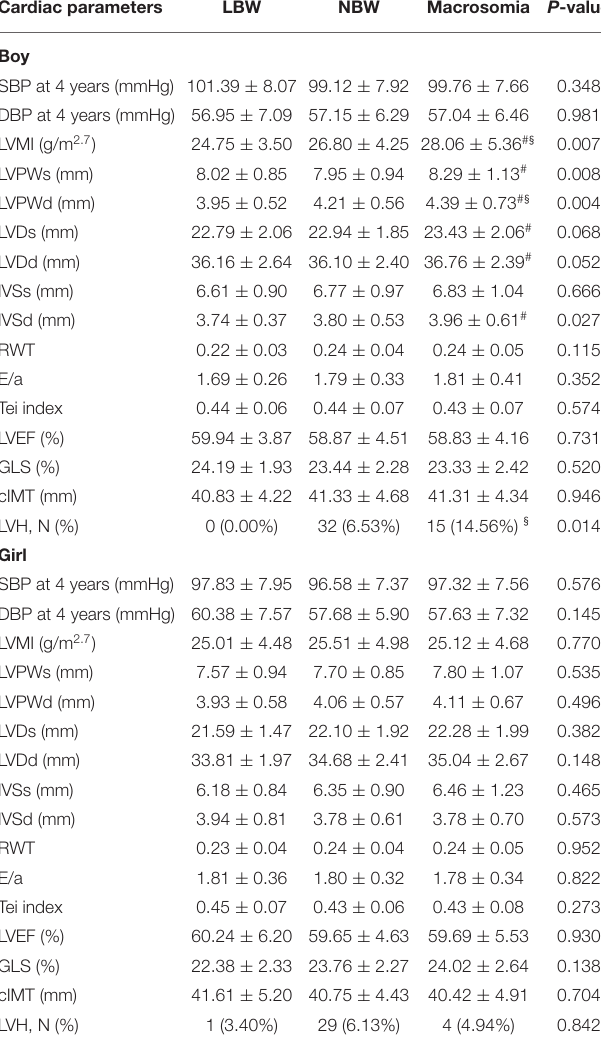
TABLE 2 | Sex-specific basic and cardiovascular characteristics of different birthweight groups. Cardiac